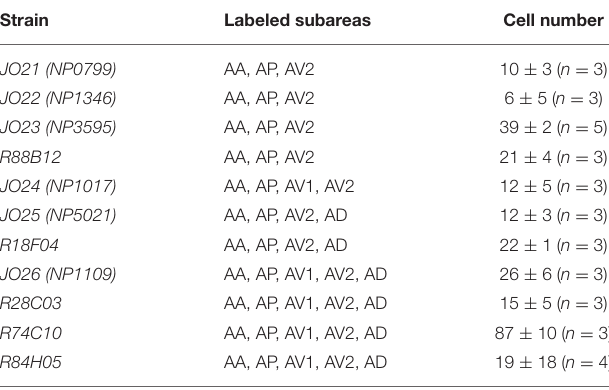
TABLE 2 | Subareas and cell numbers labeled in each JO-A strain. Strain Labeled